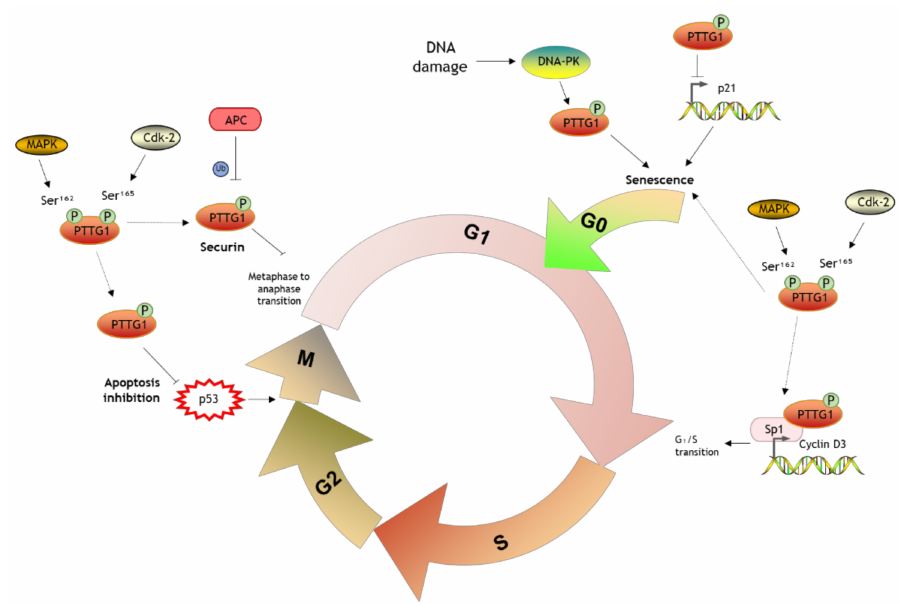
Figure 2. Schematic representation of the role of PTTG1 in cell cycle